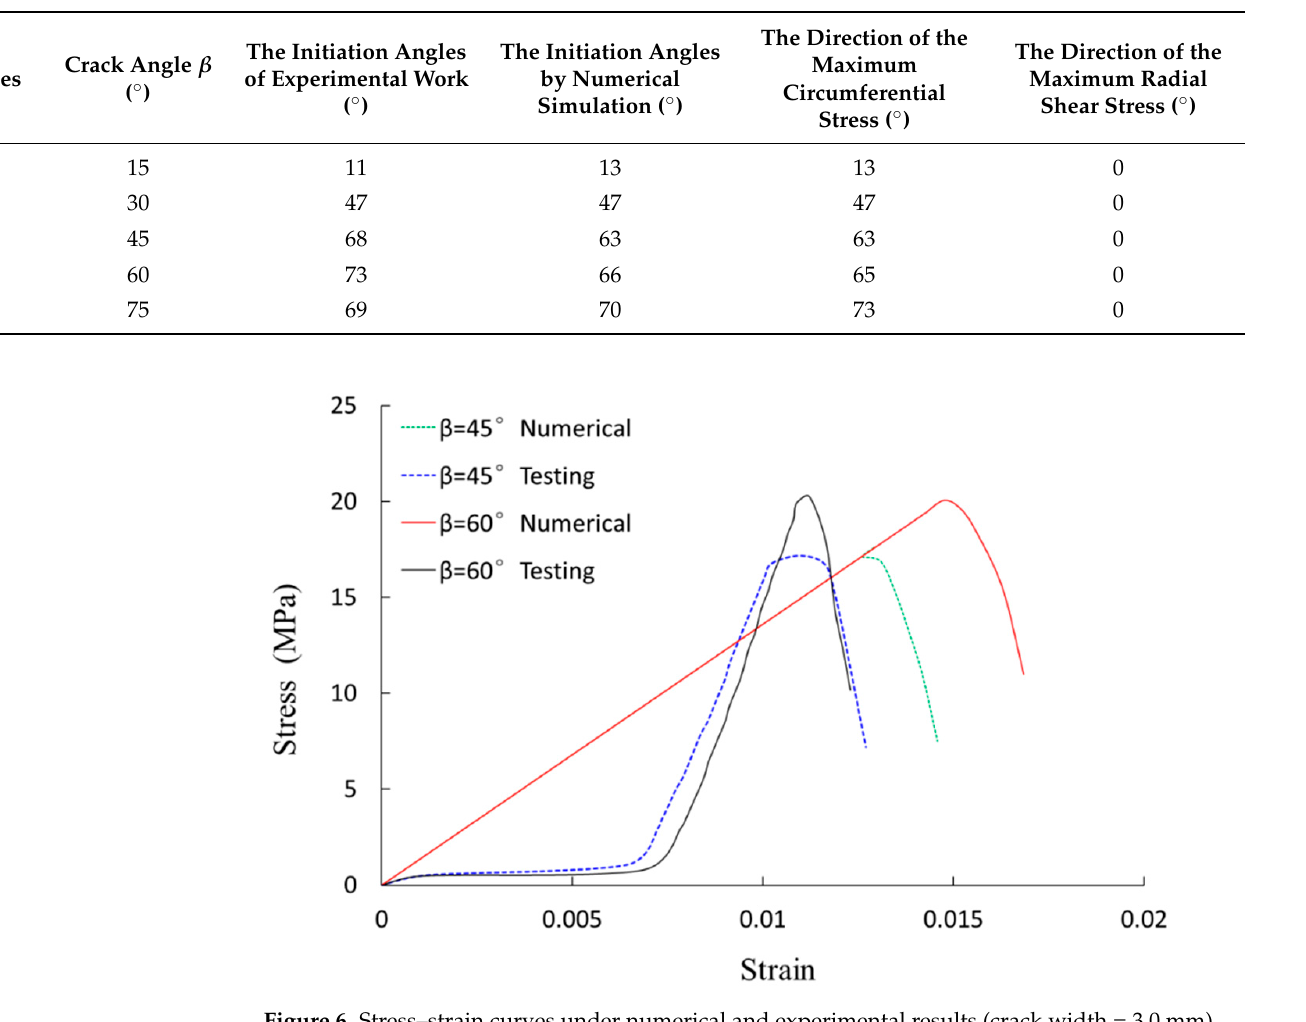
Table 6. Initiation angles derived from experimental tests and numerical simulation.